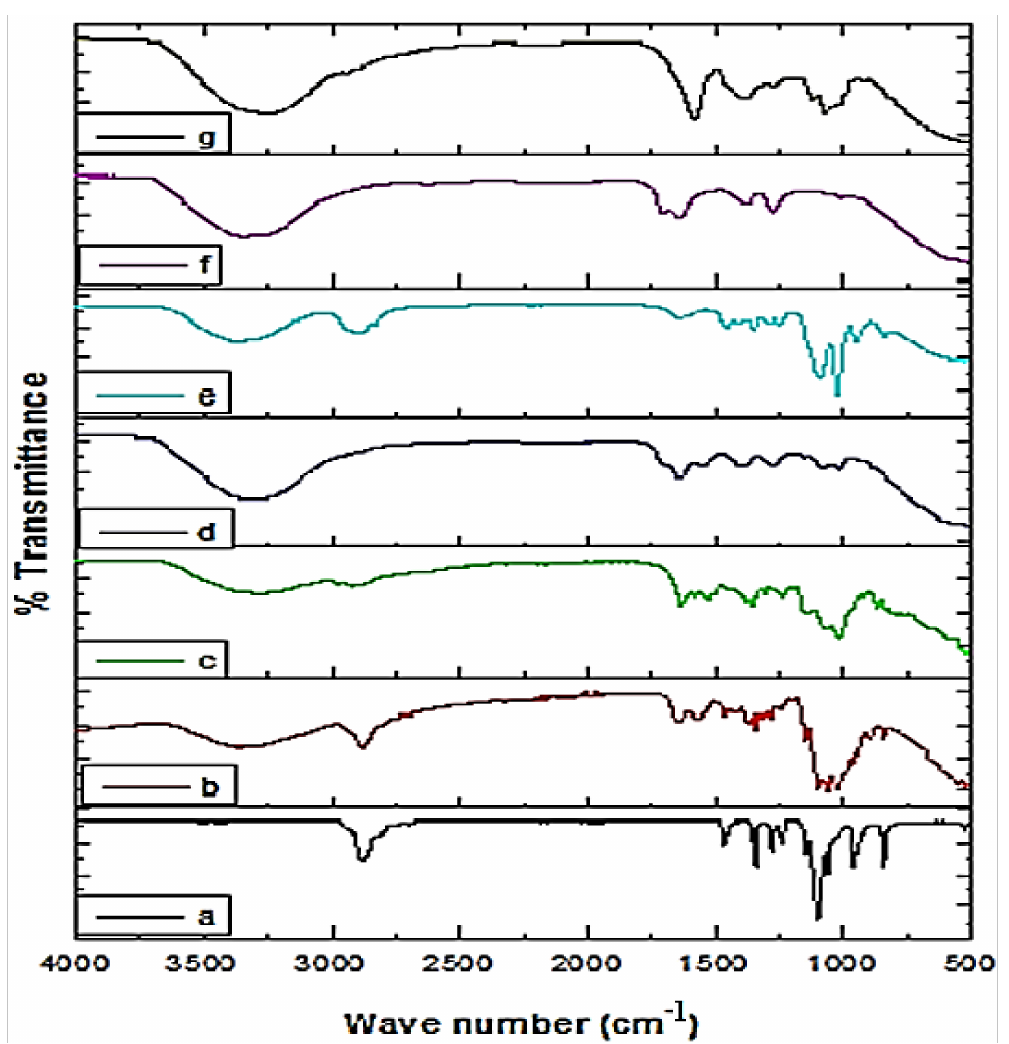
Figure 6. FTIR spectra of PEG ( a ), chitosan ( b ), LGB ( c ), Ext+Ch NPs ( d ), Ext+PEG NPs ( e ), Ext+LBG NPs ( f ), and crude extract ( g